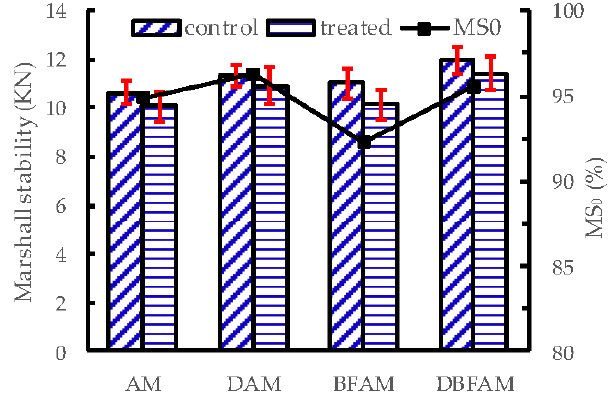
Figure 12. MS 0 of asphalt mixtures.